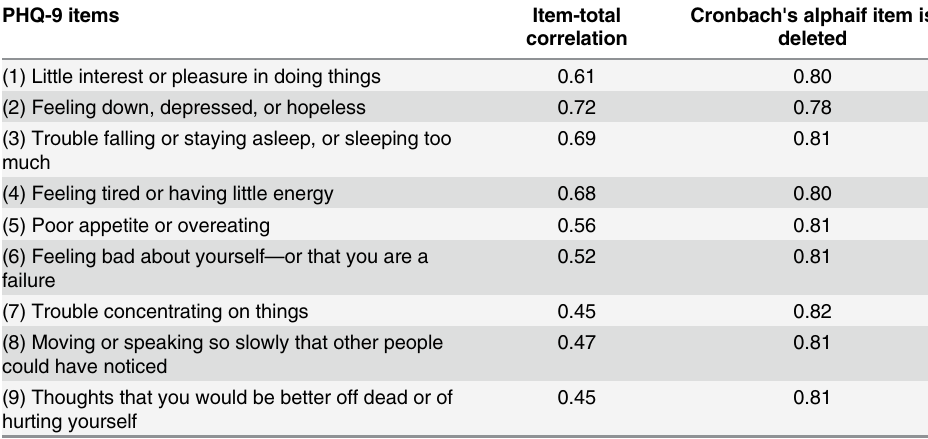
Table 2. Item analysis of PHQ-9.